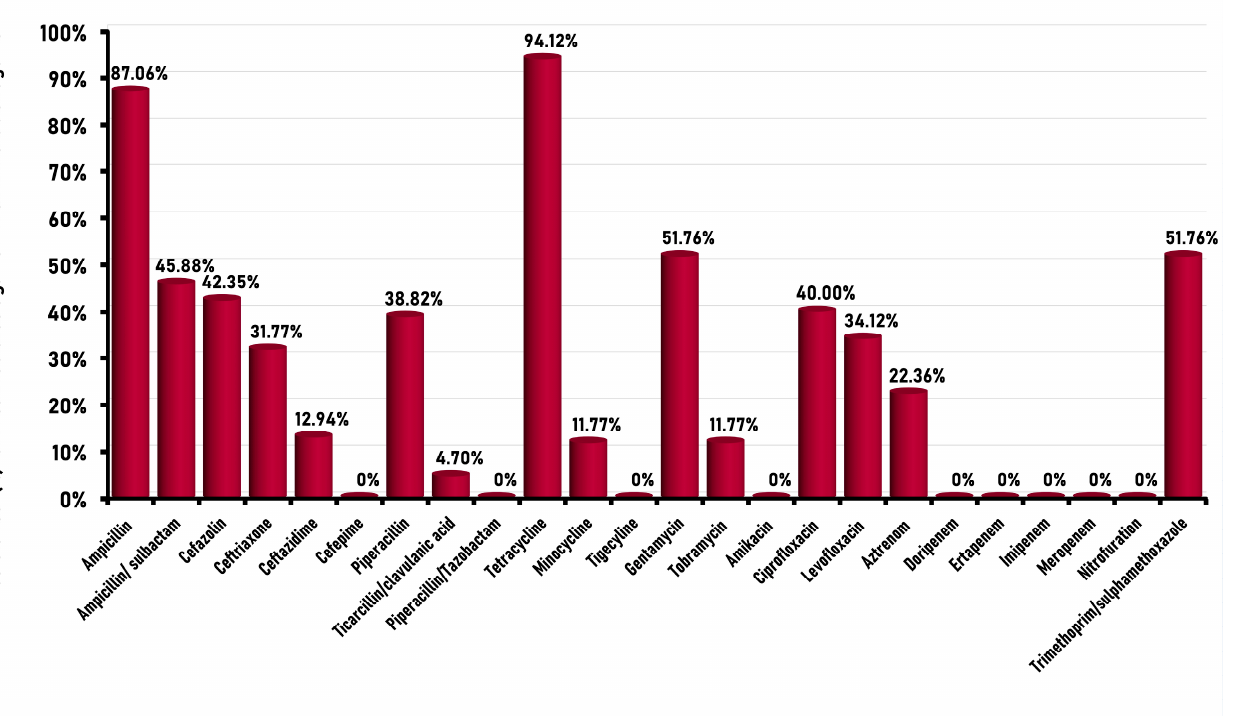
Figure 2. Antimicrobial resistance profiles of E. coli derived from poultry carcasses ( n = 85) tested against 24 antibiotics in Egypt: ampicillin (R ≥ 32 µg/mL), ampicillin/sulbactam (R ≥ 32/16 µg/mL), doripenem (R ≥ 4 µg/mL), ticarcillin/clavulanic (R ≥ 128/2 µg/mL), aztreonam (R ≥ 16 µg/mL), cefazolin (R ≥ 32 µg/mL), ceftriaxone (R ≥ 4 µg/mL), ceftazidime (R ≥ 16 µg/mL), cefepime (R ≥ 16 µg/mL), ciprofloxacin (R ≥ 4 µg/mL), levofloxacin (R ≥ 8 µg/mL), piperacillin (R ≥ 128 µg/mL), gentamicin (R ≥ 16 µg/mL), tetracycline (R ≥ 16 µg/mL), tobramycin (R ≥ 16 µg/mL), amikacin (R ≥ 64 µg/mL), piperacillin/tazobactam (R ≥ 128/4 µg/mL), ertapenem (R ≥ 2 µg/mL), trimethoprim/sulphamethoxazole (R ≥ 4/76 µg/mL), imipenem (R ≥ 4 µg/mL), minocycline (R ≥ 16 µg/mL), meropenem (R ≥ 4 µg/mL), nitrofurantoin (R ≥ 128-µg/mL), tigecycline (R ≥ 2 µg/mL). The minimum inhibitory concentration (MIC) breakpoints were carried out according to the CLSI [28] and EUCAST [29] guidelines; R: resistant.